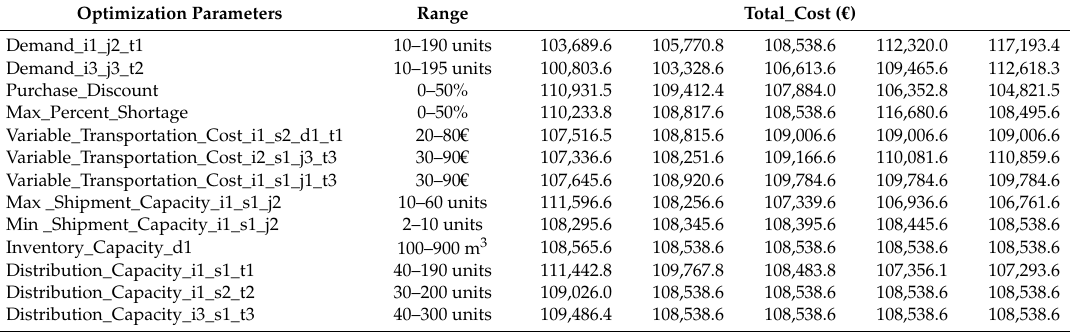
Table 4. Multiple optimization analysis report of varying all selected parameters one at a time (65 runs in total).